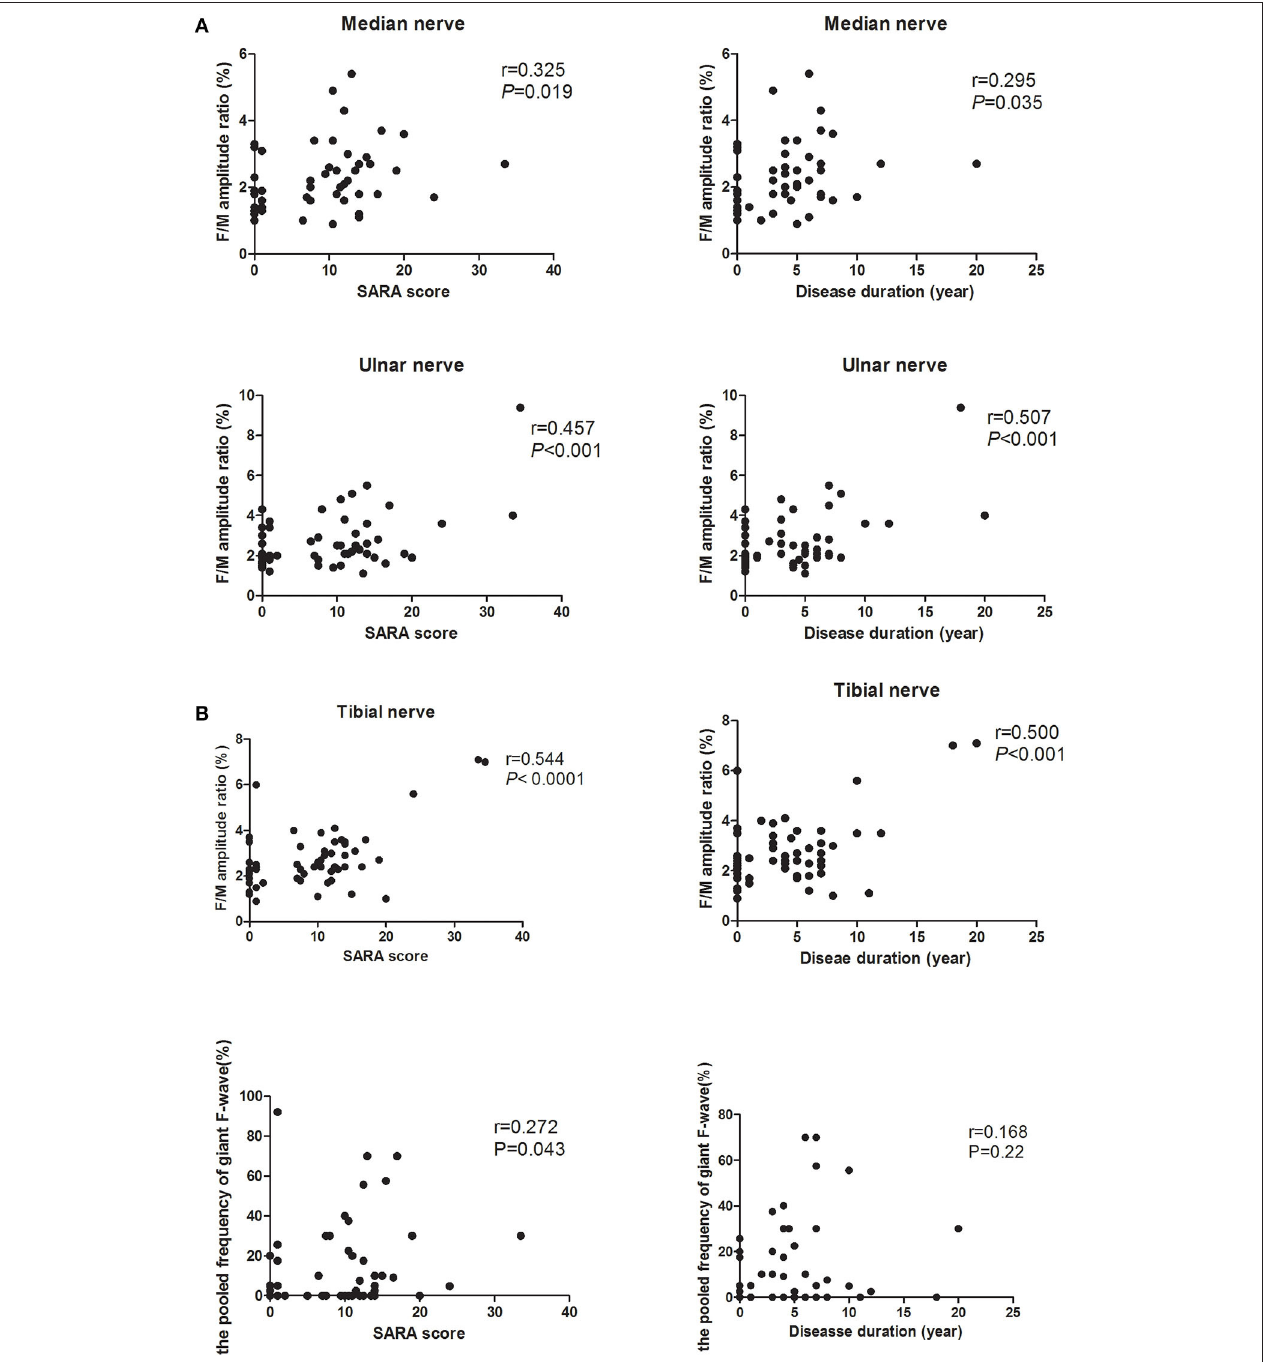
FIGURE 2 | Correlation of F-wave parameters between the disease severity and disease duration. (A) Correlation of F/M amplitude ratio in both median, ulnar, and tibial nerves between the disease severity and disease duration. It shows that the higher SARA score and the longer disease duration in a recording, the higher the F/M amplitude ratio. (B) Correlation between the pooled frequency of giant F-wave and the disease severity or disease duration.